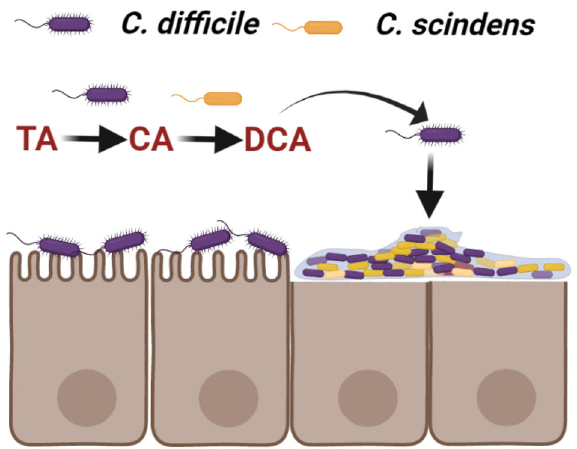
Fig. 8 Working model for DCA-mediated dual-species bio fi lm formation. The ability of C. dif fi cile to deconjugate TA during colonization “ seeds ” the gut environment with CA to be used by C. scindens during gut microbiome recovery. The presence of DCA signals a potentially non-conducive environment for C. dif fi cile growth and the bacteria forms a DCA-mediated bio fi lm to persist in the gut. Created with